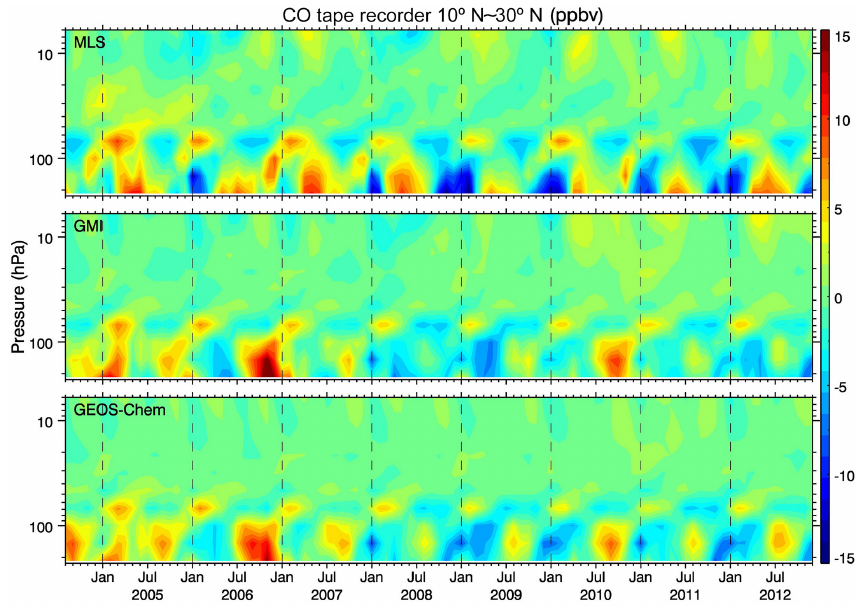
Figure 10. As in Fig. 9, but over the northern subtropics (10 ◦ –30 ◦